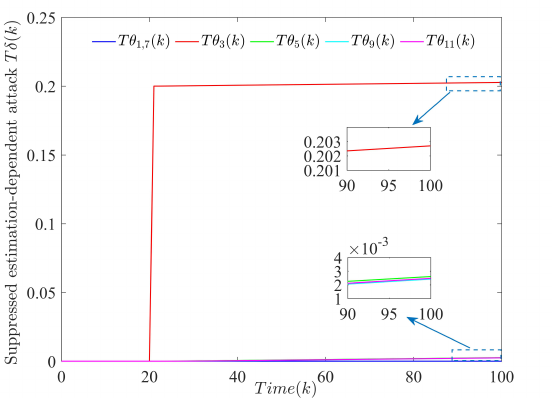
Figure 11. The suppressed estimation-dependent attack using the proposed strategy.